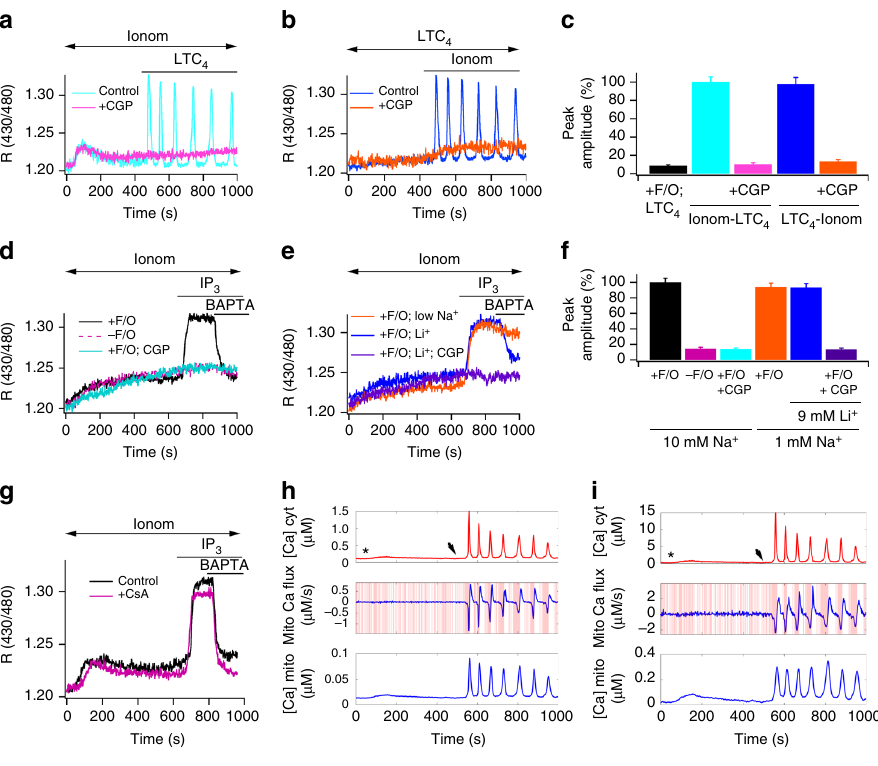
Fig. 3 Forward and reverse mode Na + – Ca 2+ exchanger. a After knockdown of MCU and MFN2, matrix Ca 2+ oscillations are induced by LTC 4 in FCCP- treated cells following a small rise in matrix Ca 2+ by 2 nM ionomycin. Oscillations were seen in 15/24 cells. CGP-37157 suppressed this response (15/15 cells). b As in panel a but LTC 4 is now applied fi rst. Oscillations were seen in 10/15 cells. CGP-37157 blocked the response in 18/18 cells. c Aggregate data are compared. All groups were pre-treated with FCCP and oligomycin and both MCU and MFN2 were knocked down. Ionom-LTC 4 denotes ionomycin followed by LTC 4 (as in panel a ). LTC 4 -Ionom denotes LTC 4 then ionomycin, as in panel b . d Matrix Ca 2+ is measured in permeabilised cells following stimulation with InsP 3 . Cytosolic Na + was 10 mM and cytosolic Ca 2+ was weakly buffered at 200 nM. Ionomycin was applied to raise matrix Ca 2+ , then InsP 3 was added. F/O denotes FCCP/oligomycin. BAPTA was perfused to rapidly reduce cytosolic Ca 2+ . e As in panel d , but cytosolic Na + was 1 mM. In the experiments with Li + , 9 mM Li + was added to the 1 mM Na + solution. f Aggregate data from experiments as in panels d and e are compared. Each bar denotes between 15 and 23 cells. g Ca 2+ signals in permeabilised cells are compared in the absence and presence of cyclosporine A (1 μ M). Here, mitofusin 2 had been knocked down and FCCP/oligomycin added 5 – 10 min before simulation with InsP 3 . Control trace is in the absence of cyclosporine A. For both traces, 1 μ M ruthenium red was present throughout. h Simulations of Na + – Ca 2+ exchanger fl ux (middle panel, with pink highlighted background showing where NCX is operating in reverse mode) and matrix free Ca 2+ (bottom panel) following a cytosolic Ca 2+ rise (upper panel) obtained from fura 2-loaded intact cells. Cells were exposed to 2 nM ionomycin (asterisk) before LTC 4 challenge (marked by arrow; same protocol as in panel a ). The cytosolic Ca 2+ concentration indicated is the measured bulk concentration. i As in panel h but cytosolic Ca 2+ has been estimated to reach 15 μ M (see text). Error